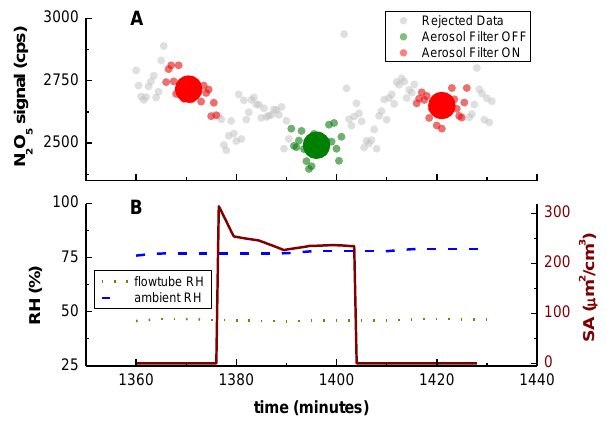
Fig. 2. (A) Select data illustrating the capabilities and precision of the reactivity apparatus over a single aerosol filter ON/OFF/ON cy- cle. Aerosol Filter ON indicates particles are not present in the flow reactor. Aerosol Filter OFF indicates when the reactor is sampling ambient particles. The size of the three large markers represents the 95% confidence range of signals incorporated in the average. (B) Ambient RH (blue dashed line), calculated flow reactor RH (olive dotted line), and particle surface area concentrations are shown for the same period. Surface area is only shown for the Filter OFF sta- tus and set to zero for the Filter ON status to illustrate the particle surface areas within the flow